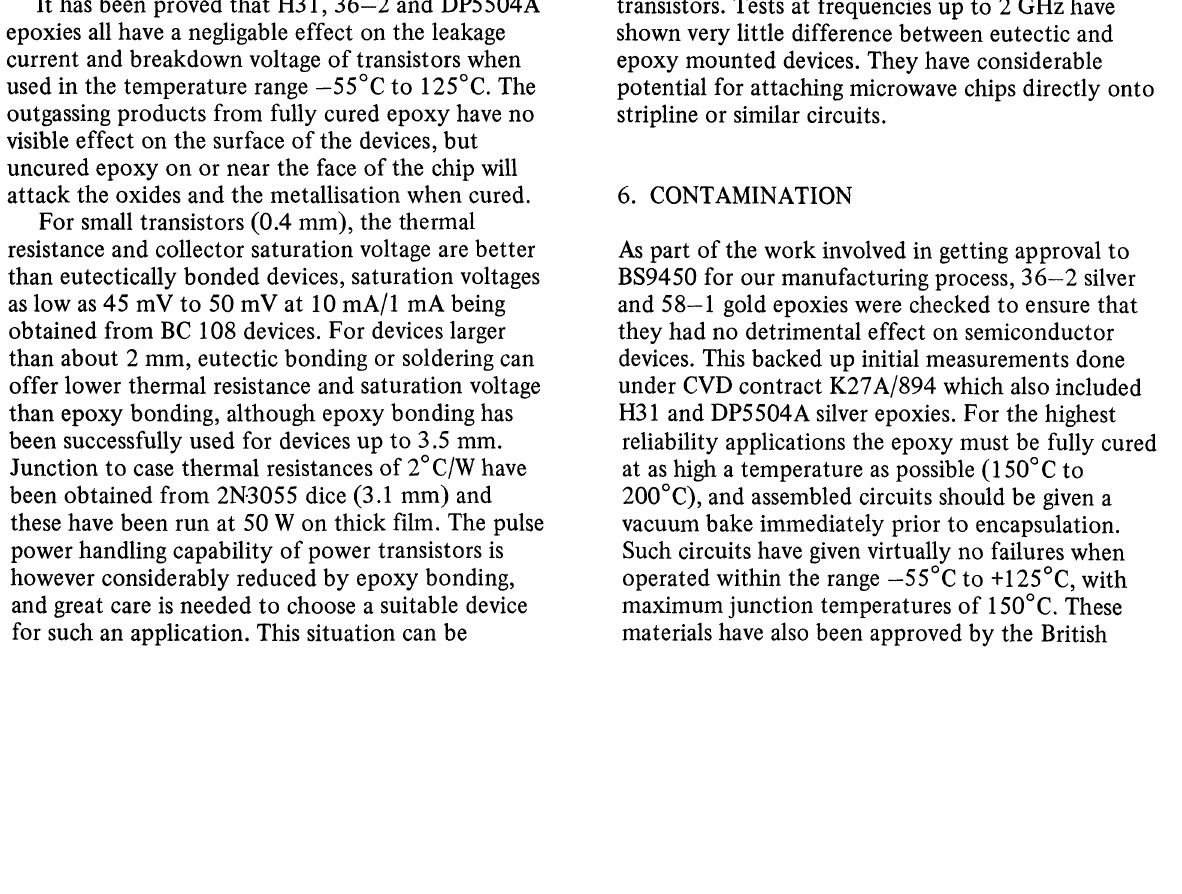
FIGURE 4 Environmental test